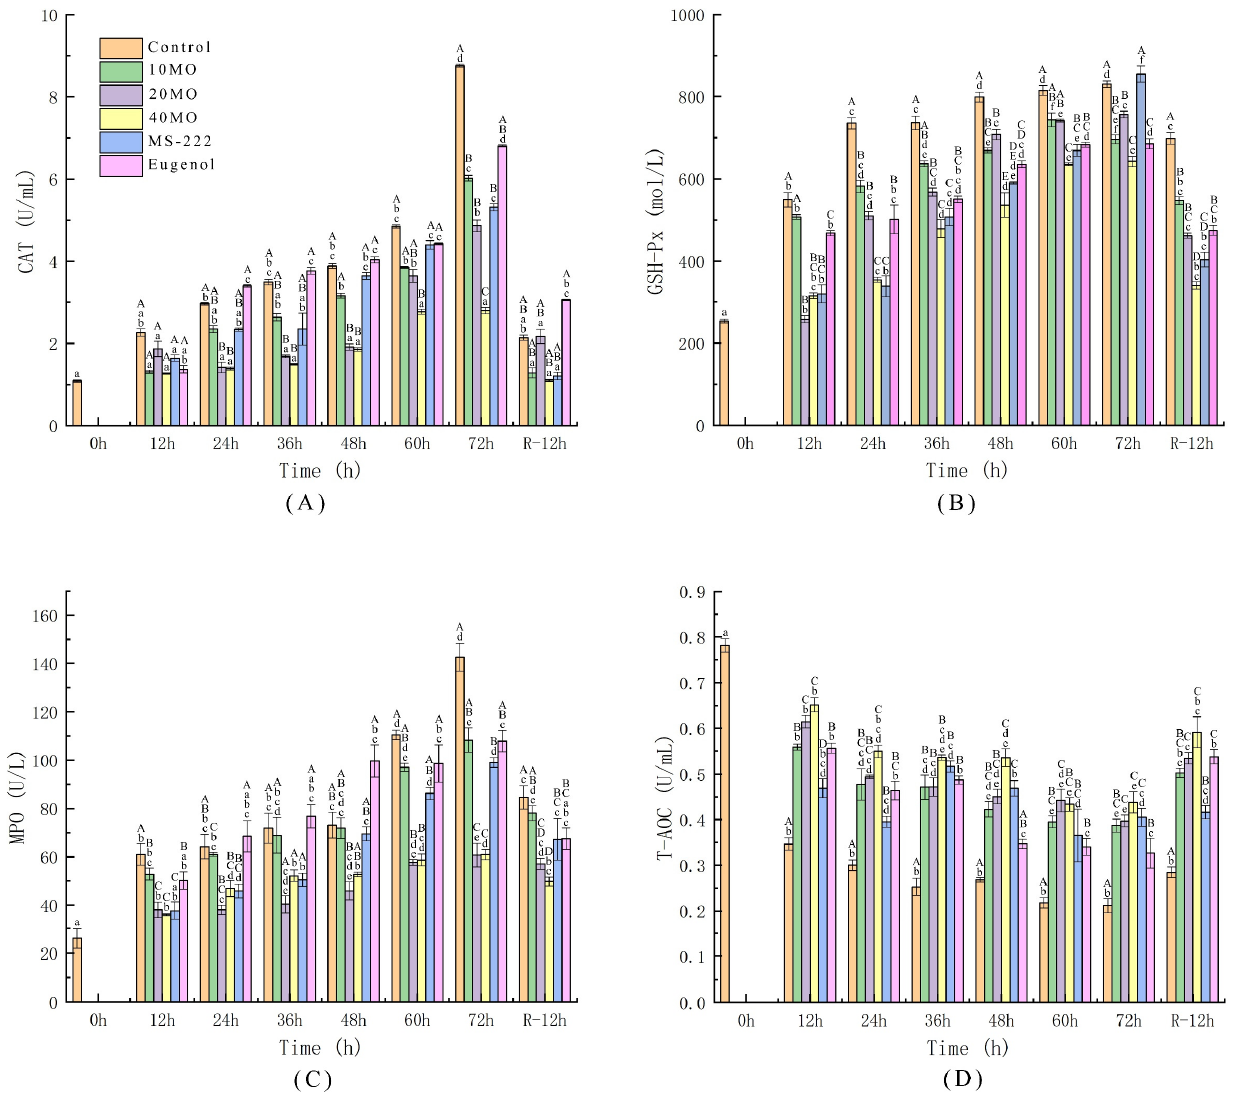
Figure 3. The activity changes in CAT ( A ), GSH-Px ( B ), MPO ( C ), and T-AOC ( D ). 10 MO: 10 mg/L MOEO, 20 MO: 20 mg/L MOEO, 40 MO: 40 mg/L MOEO, MS-222: 30 mg/L MS-222, eugenol: 20 mg/L eugenol, control: no agent addition. Vertical bars indicate the standard deviation; Means with different lowercase letters indicate a significant difference between the time intervals within each group ( p ≤ 0.01) while different capital letters indicate significant differences between groups in each time interval ( p ≤ 0.01).